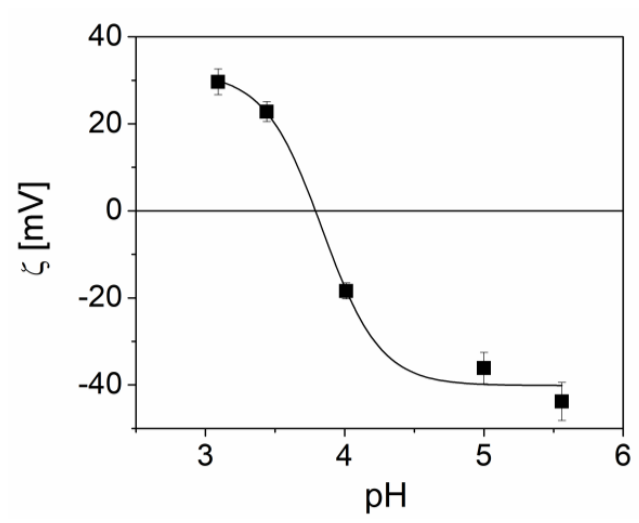
Figure 2. pH dependence of ζ -potential of carbon sphere particles in a 0.1 g / L aqueous suspension.